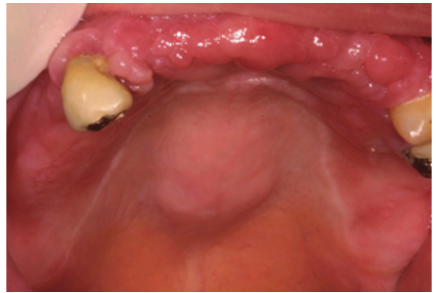
Figure 5: TP: aspect of the lesion before intervention.